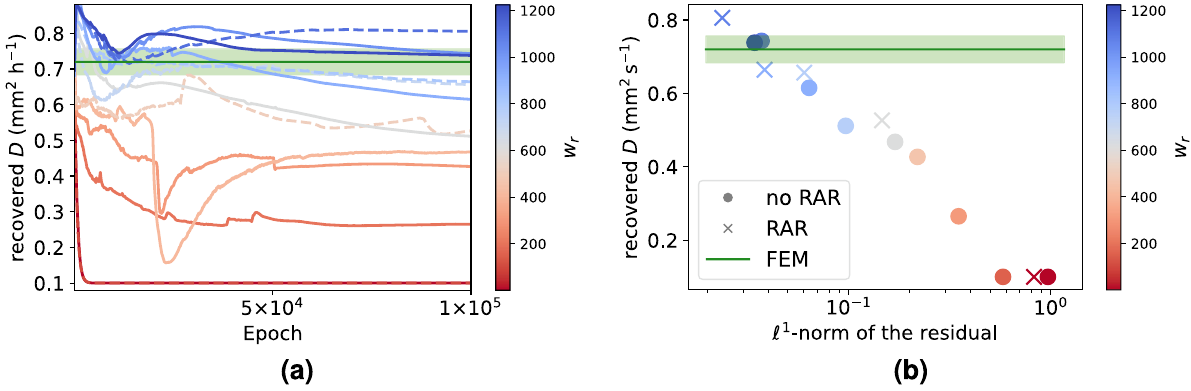
Figure 4. Influence of PINN hyperparameters on the diffusion coefficient estimated from clinical data. ( a ) Diffusion coefficient during training for different PDE weights w r and exponentially decaying learning rate from 10 − 4 to 10 − 5 . Dashed lines indicate result with residual based adaptive refinement (RAR). ( b ) Estimated diffusion coefficient with p = 2 for different PDE weights w r as a function of the ℓ 1 -norm of the residual after training. The values for FEM and the green horizontal bars indicating an error estimate are taken from Valnes et al. 28